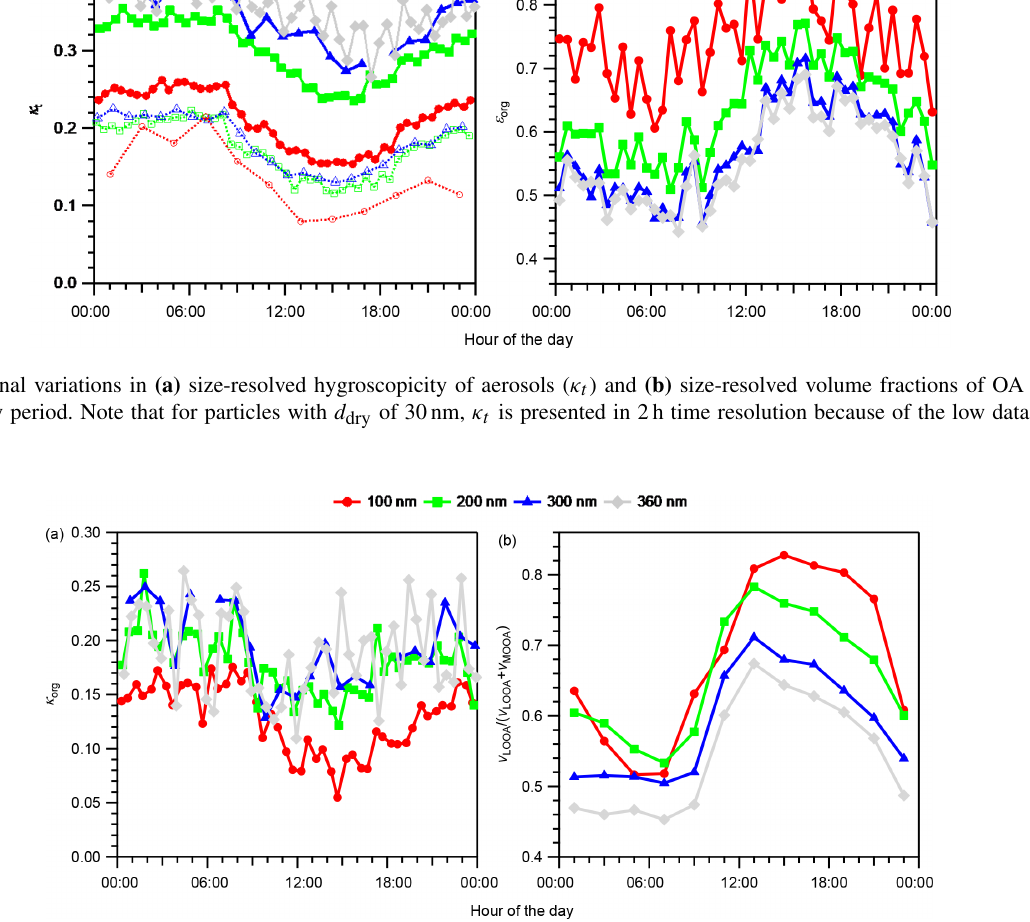
Figure 4. Diurnal variations in (a) size-resolved hygroscopicity of OA ( κ org ) and (b) size-resolved volume fractions of LOOA in OA ( v LOOA / ( v LOOA + v MOOA ) ) for the entire study period. For κ org in panel (a) , only data with ε org >0.40 were considered. The values in panel (b) were calculated from the diurnal variations in the average volume concentrations of LOOA and MOOA (Fig. S16), not from the averages of v LOOA / ( v LOOA + v MOOA